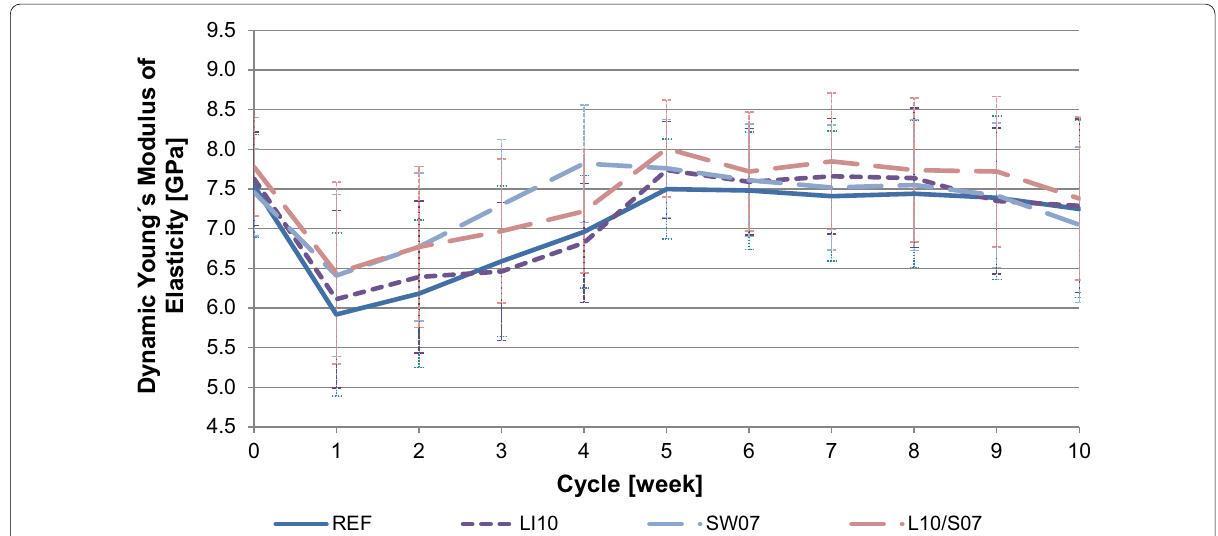
Fig. 16 Comparison of dynamic Young’s elasticity modulus of cement-bonded particleboards exposed to wet–frost–dry cycling in accordance with EN321